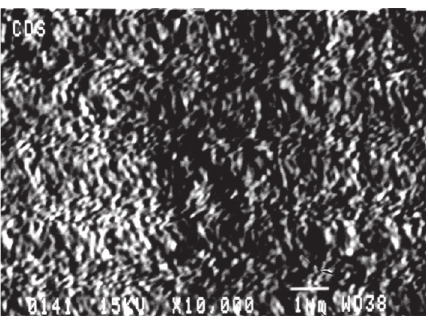
Figure 3: SEM image of a CdS film deposited using the UCCD method at 15kV. The scale is 1 mm.